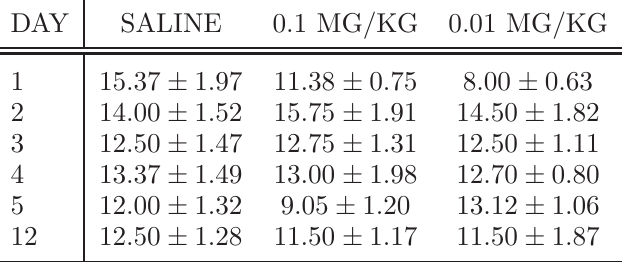
Table 5 Effects of CGP76290 on active avoidance test.